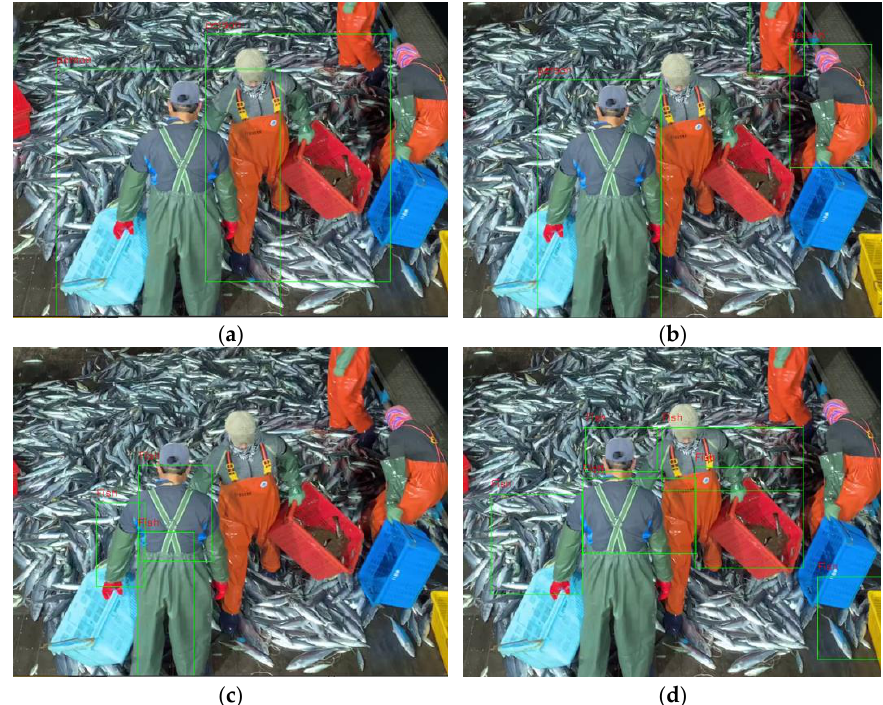
Figure 3. A comparison of cropped and uncropped images.